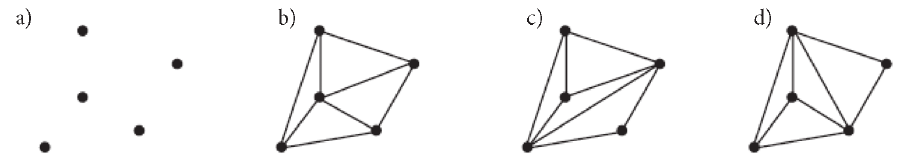
Fig. 7. Different triangle networks created by the same initial data (a), whereas b, c, and d are different results depending on the placement of the triangles (Li et al .